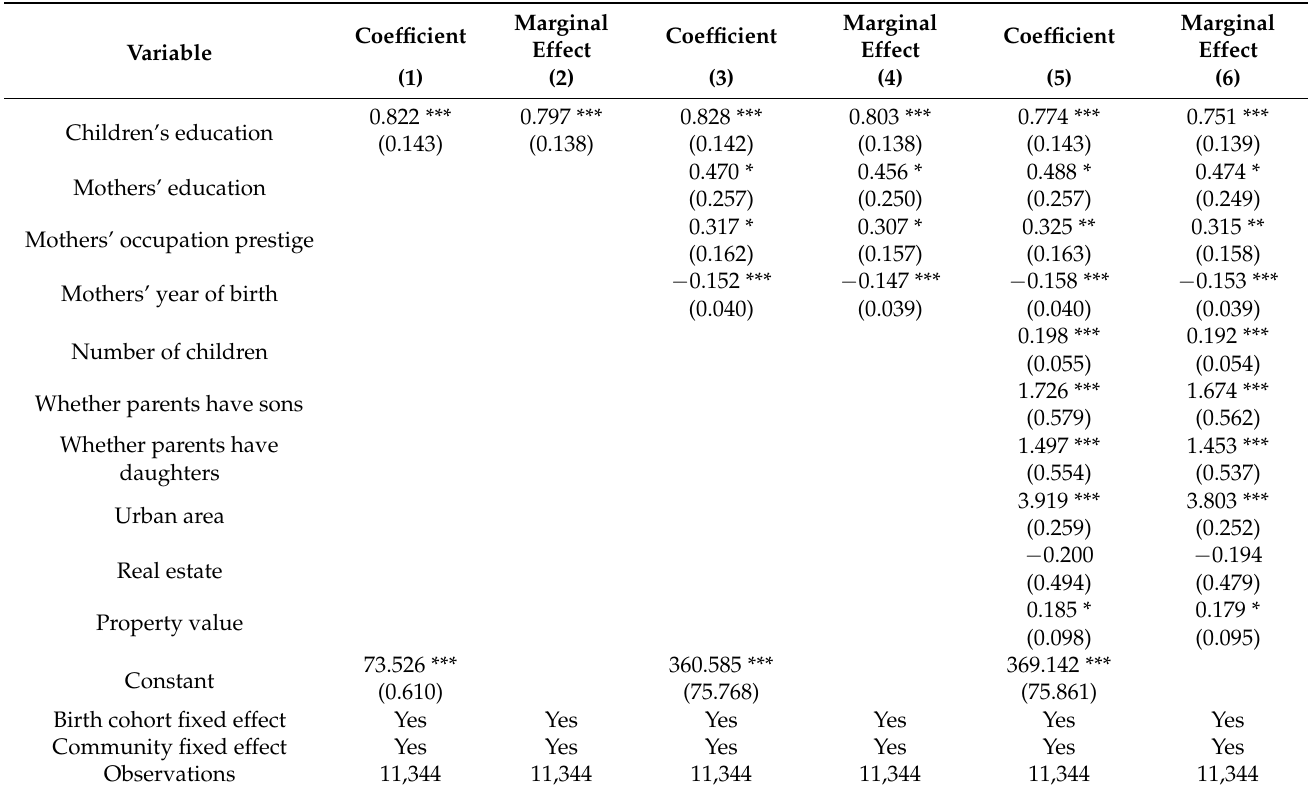
Table 3. Estimation results of adult children’s education on mothers’